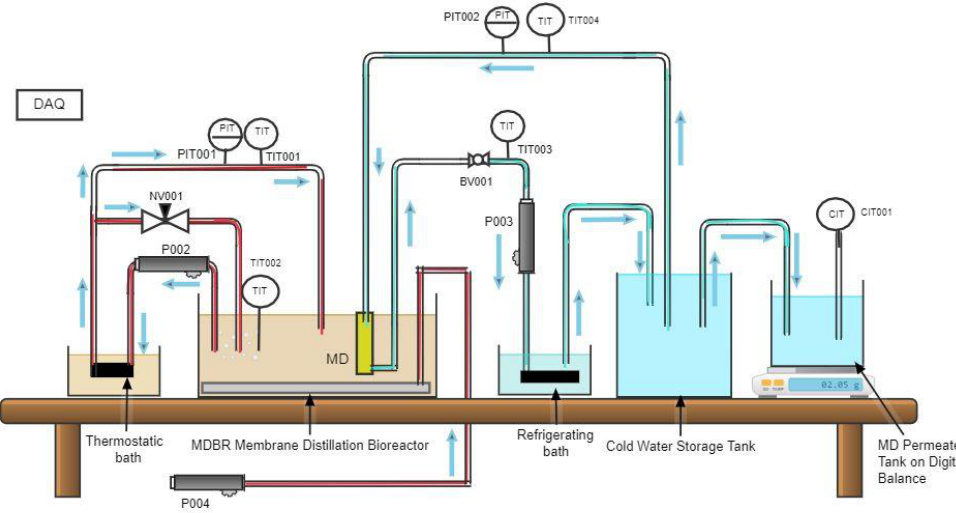
Figure 4. Schematic of the hybrid submerged MDBR configuration 2 used in Experiment 3. (PG00x: pressure gauge; P00x: pump; NV00x: needle valve; R001: air flow meter, R002: water flow meter; PIT00x: pressure transducer; TIT00x:. thermocouples; CIT001: conductivity transmitter. DAQ: data acquisition).